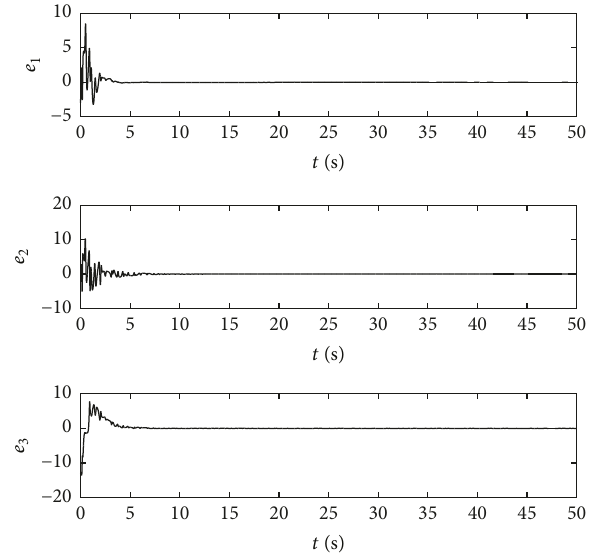
Figure 1: Synchronization errors between two L¨u chaotic systems; the full-order hybrid synchronization is